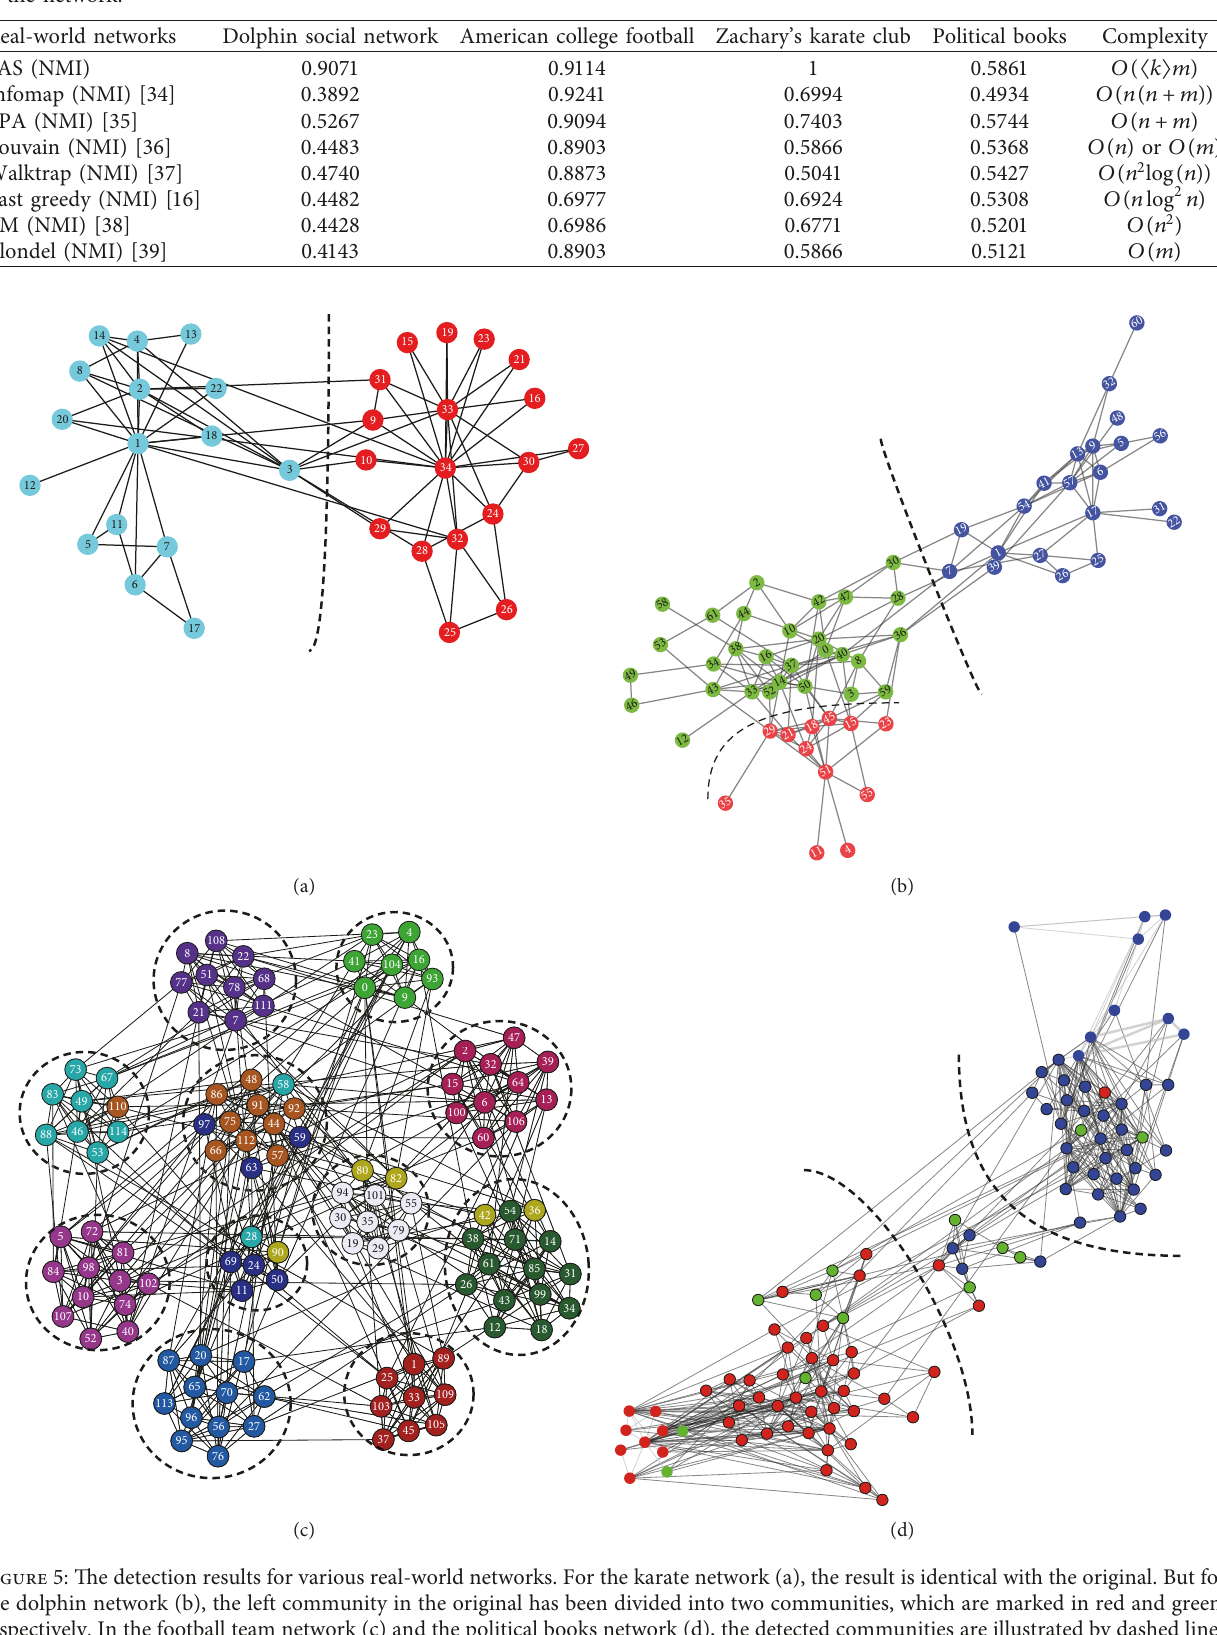
Table 2: Performance comparison in real-world networks, where n and m are the number of nodes and edges and < k > is the average degree of the network.